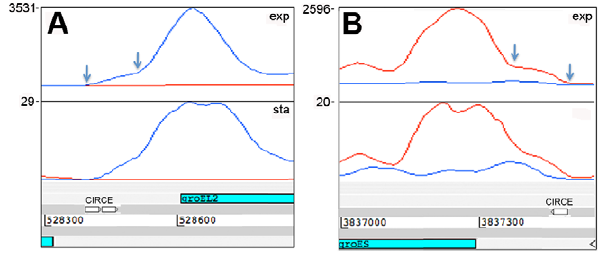
Figure 4. 5’ UTRs of heat shock chaperones. Transcription of groEL2 (panel A) and groES (panel B) is associated with long 5’-leader sequences that include the CIRCE motifs involved in heat shock regulation. Arrows indicate the putative transcription start sites based on signal start and increase in slope, respectively, suggesting that there are CIRCE-dependent and CIRCE-independent transcription start sites for these genes. Genome locations are indicated below and maximum expression in exponential and stationary phases are shown on the y- axis.